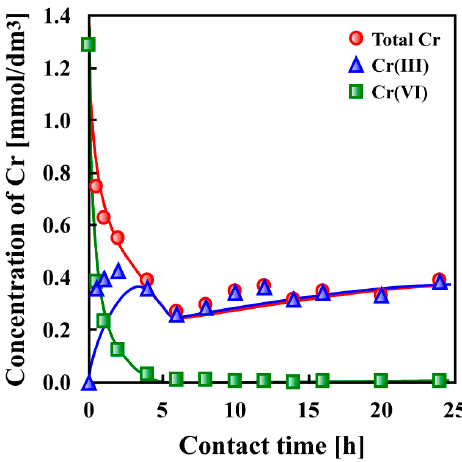
Figure 36. Temporal change in the % adsorption of Cr(VI) by crosslinked persimmon gel at different pH values at 30 °C . Initial Cr(VI) concentration = 13 mM, weight of gel = 10 mg, test solution volume = 10 mL [35]. (With permission for reuse from Elsevier B.V.).